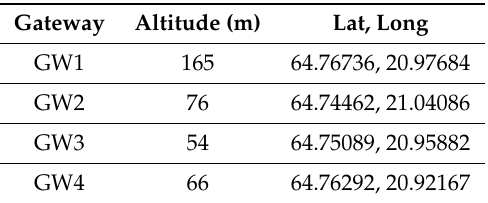
Table 2. Gateways